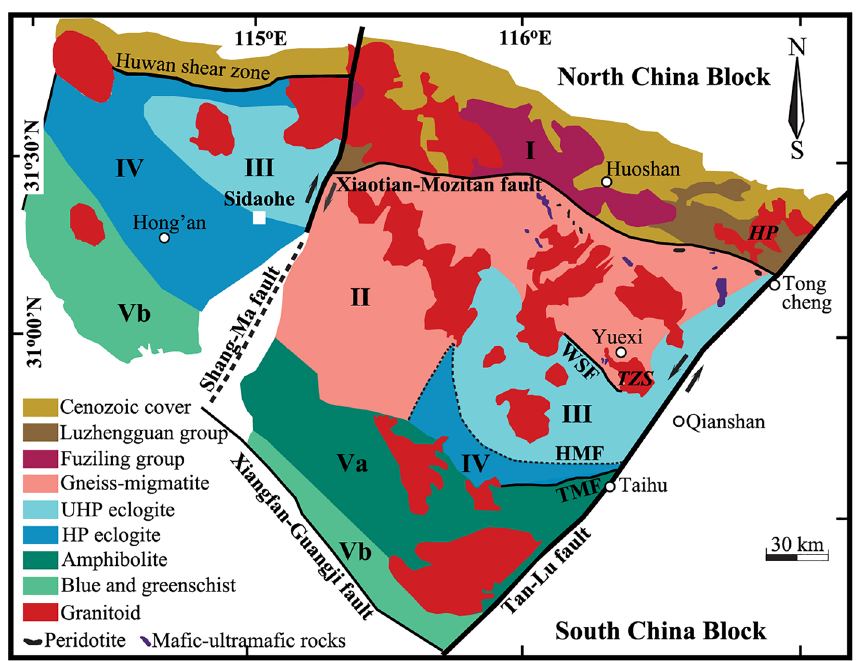
Figure 1. Geological sketch of the Dabie orogen in central-eastern China modified from Refs. 18–20 . In terms of field relation and lithological assemblage, geologic units bounded with faults were divided. Traditionally, the western portion beyond the Shang-Ma fault was termed Hong’an (or Xinxian) Block. The Dabie Block (DBB) is bounded by the Shang-Ma fault in the west and the Tan-Lu fault in the east. From north to south, the DBB was further subdivided into five belts: I. the Northern Huaiyang volcanic-sedimentary belt (flysch series); II. the Northern Dabie gneissic and migmatitic belt; III. the Central Dabie ultrahigh pressure (UHP) metamorphic belt; IV. the Southern-central Dabie high pressure metamorphic belt; and V. the Southern Dabie intermediate- to low-grade metamorphic belt, respectively. WSF Wuhe-Shuihou fault, HMF Hualiangting-Mituo fault, and TMF Taihu-Mamiao fault. Bold italic capital letters denote the abbreviations of studied plutons, other details refer to Table S1. This figure was generated with Adobe Photoshop CS3 Extended version 10.0 (https:// www. adobe. com/ cn/ produ cts/ photo shop.